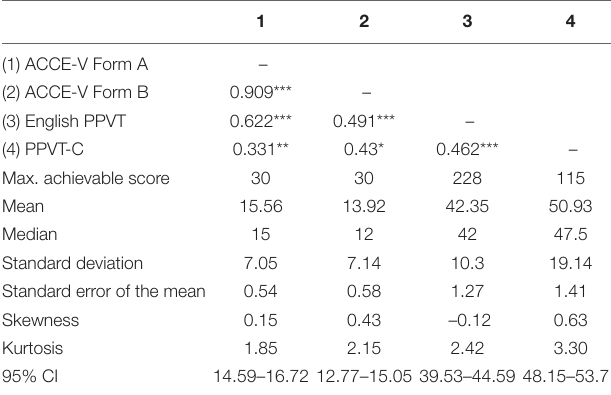
TABLE 3 | Correlations and descriptive statistics for the four tests (ACCE-V Form A, ACCE-V Form B, PPVT-4, and